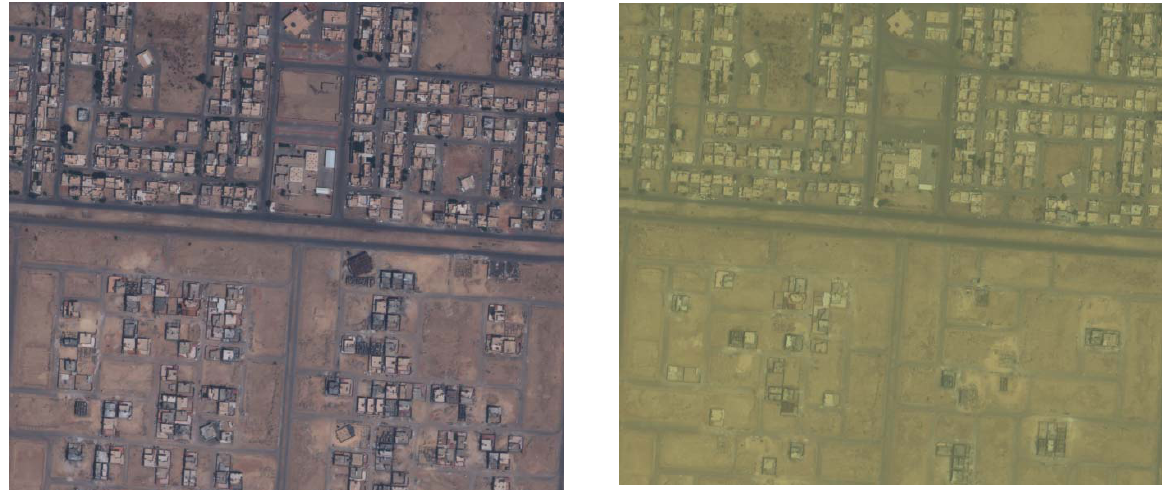
Figure 2: Subsets of GeoEye (left) and Ikonos (right) satellite image used for the investigations.